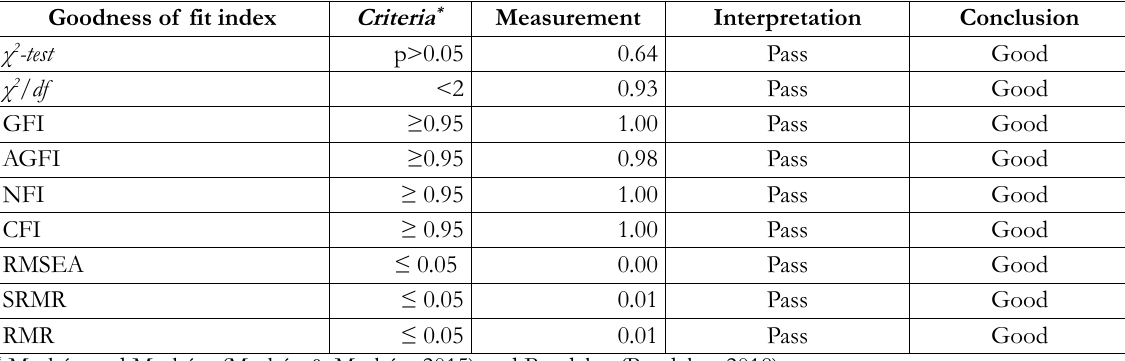
Table 3. Goodness of fit statistics between the model components and empirical data Table 3 indicated that all the goodness of fit statistical values between the model components and empirical data passed the criteria. When accounting the χ 2 -test value which has no statistical